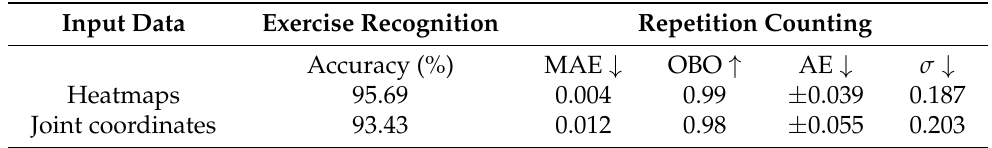
Table 7. Results of exercise recognition and counting using different inputs: heatmaps and joint